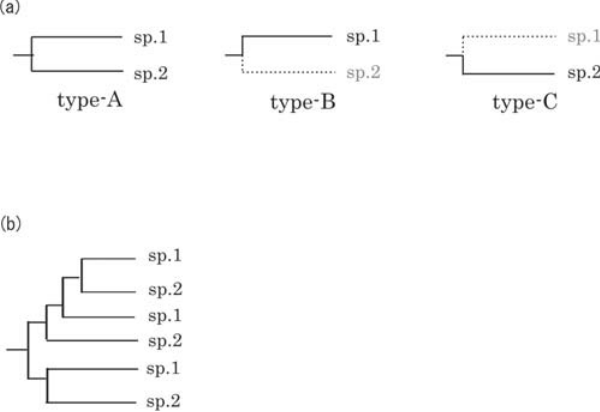
Figure 4. Three phylogenetic subtree types of a phylogenetic tree consisting of 2 species (sp.1 and sp.2). Genes derived from intraspecific duplications are considered to be one gene. Type-A indicates that a gene is found in both sp.1 and sp.2 lineages. Type-B indicates that orthologous genes of a gene of sp.1 are not found in sp.2. Type-C indicates that orthologous genes of a gene of sp.2 are not